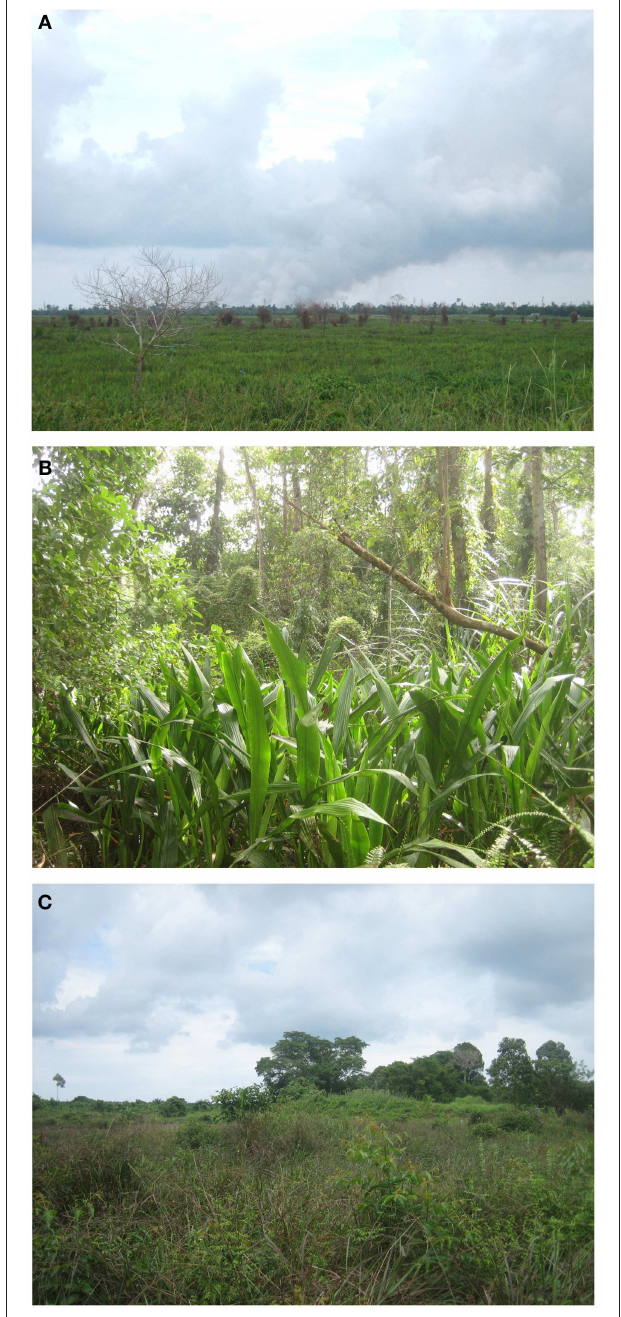
FIGURE 2 | Photographs of each study site: (A) Deforested Peatland, an area of degraded peatland covering > 50 km 2 (with a fire burning in the distance when this photograph was taken); (B) Peat Swamp Fragment, a c. 2 km 2 fragment of secondary peat swamp forest; and (C) Converted Peatland, an agriculture-forest matrix of c. 1 km 2 (Photographs taken by